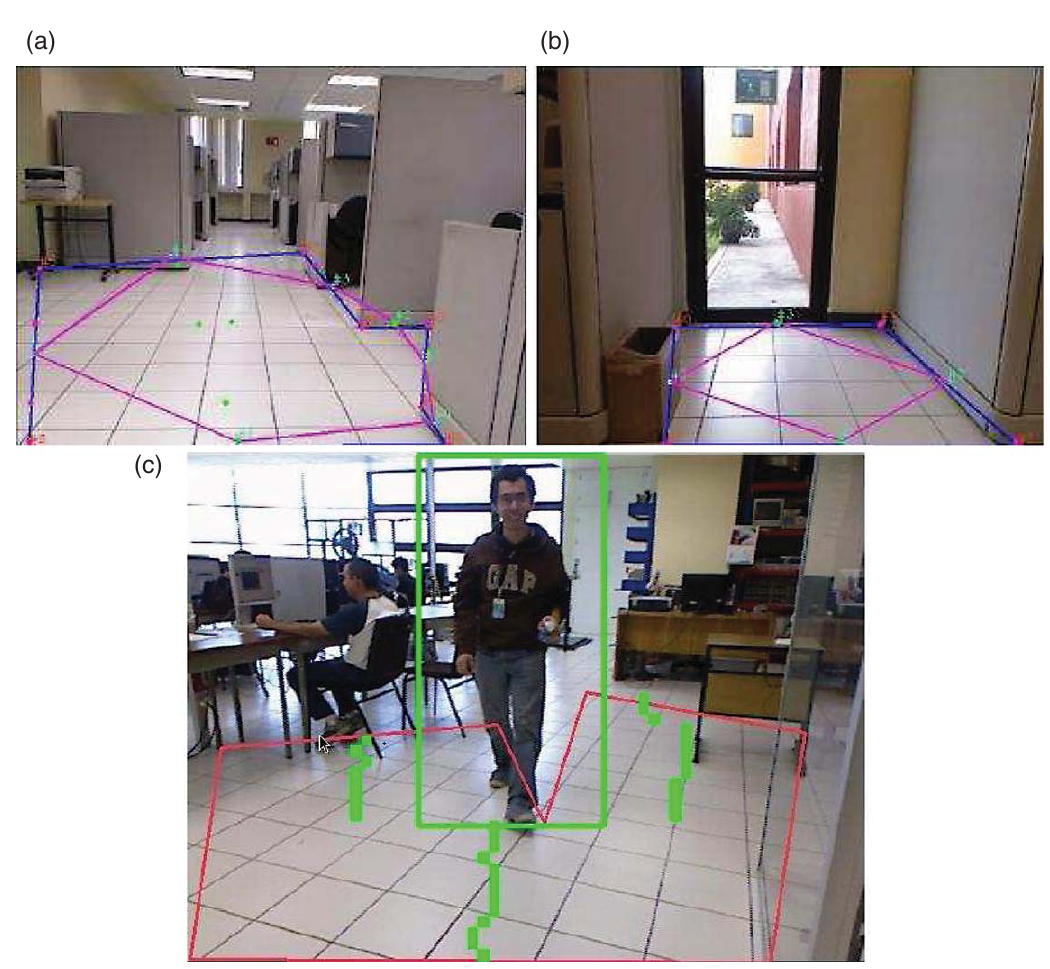
Fig. 20. Finding a path free using a polygon: a) (upper left) in an office; b) (upper right) in front of a door; c) (lower row) using SVM-HOG in front of a walking